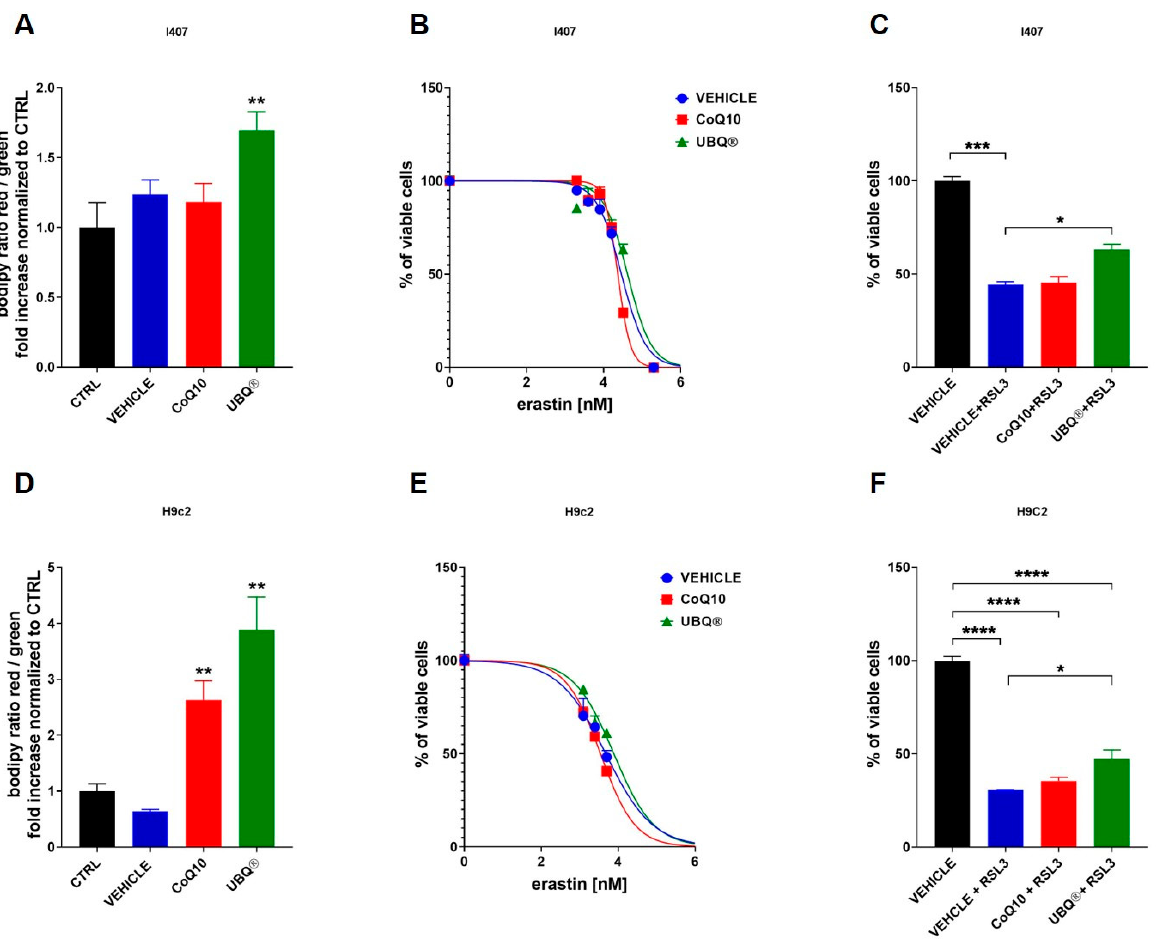
Figure 5. Lipid membrane peroxidation evaluation in I407 and H9c2. Cells were treated with 100 nM CoQ10 phytosome (UBQ), native CoQ10 (Q10) and phytosome (vehicle) or untreated as control. The peroxidation status of membrane lipids was determined using the fluorescent dye BODIPY™ 581/591 C11 in fixed I407 ( A ) and H9c2 ( D ) cells by confocal microscopy. For each condition, at least three fields were randomly selected. Quantitative analysis of Red/Green fluorescence ratio was performed using the ImageJ software. Data are presented as fold increase over untreated controls ( n = 5). The viability of I407 ( B ) and H9c2 ( E ) cells in the presence of different concentrations of the ferroptosis-inducer erastin was assessed by MTT assay after 24 h of incubation ( n = 3). The viability of I407 ( C ) and H9c2 ( F ) cells after 24 h of incubation with 1 μ M and 300 nM, respectively, of the GPX4 inhibitor RSL3 was assessed by MTT assay ( n = 3). Data are presented as a percentage of vehicle-treated viable cells. For all panels, data are presented as the mean ± s.e.m, * p ≤ 0.05; ** p ≤ 0.01; *** p ≤ 0.001; **** p ≤ 0.0001. Statistical analysis was performed using one-way ANOVA followed by Tukey’s honest significant difference test.